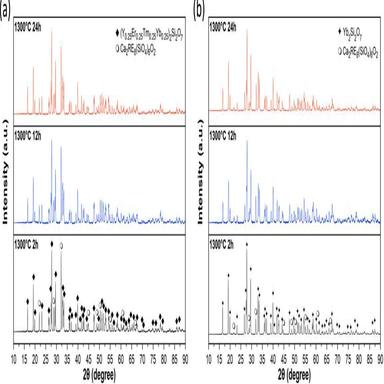
XRD patterns of (a) (Y0,25Er0,25Tm0,25Yb0,25)2Si2O7 – CMAS and (b) Yb2Si2O7 – CMAS powder mixtures after calcining at 1300 ◦C for 2, 12 and 24 h.